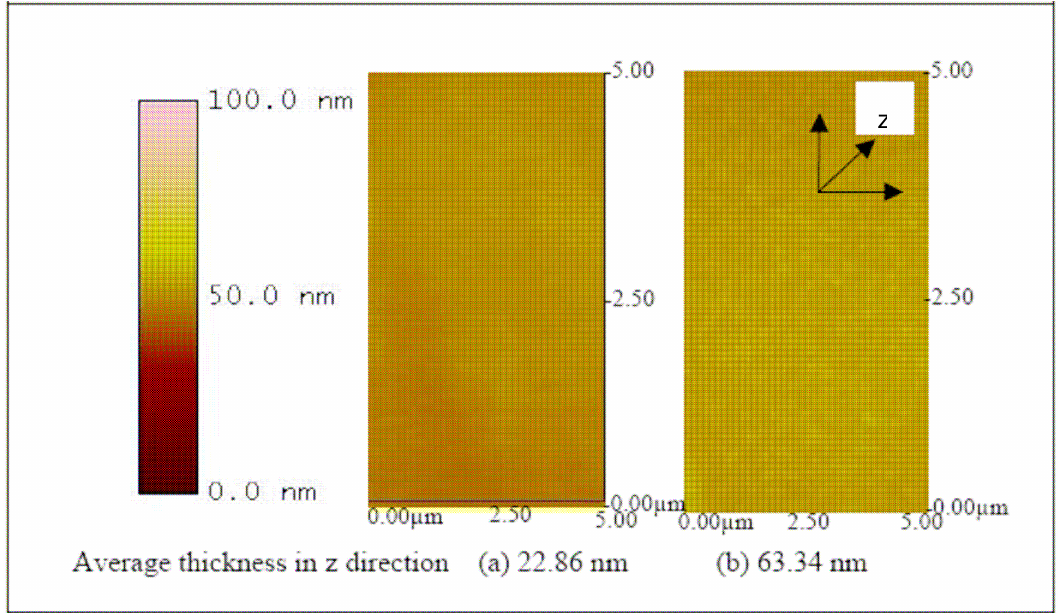
Figure 9. Atomic force microscopy images of a) untreated ITO glass and b) ITO glass treated with ammonium hydroxide (NH OH). 4